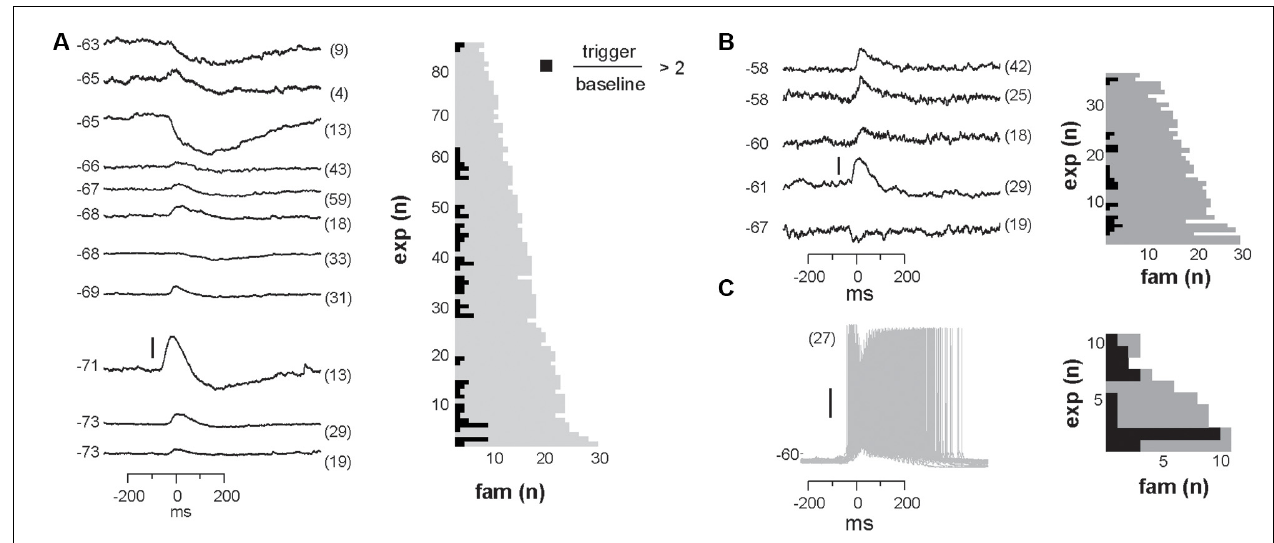
FIGURE 9 | Summary of significant membrane potential responses within each experimental group. (A) NMDA/DA condition in slices from adult rats: 42 neurons were found to receive reliable and selective input from particular avalanche families. Left: the subset of 11 family-triggered average membrane potential time courses with large amplitude changes ranked according to trigger-preceding average membrane potential shown at the left of each trace. The number of family triggers indicated by the number in brackets to the right. Note that responses could be depolarizing, hyperpolarizing or a depolarization followed by a hyperpolarization. Right: summary plot of the total number of avalanche families and the number of families with select intracellular responses. Note that most families will not trigger a response in a randomly recorded pyramidal neuron. (B) Summary for ACSF condition in slices from young rats. (C) Summary for PTX